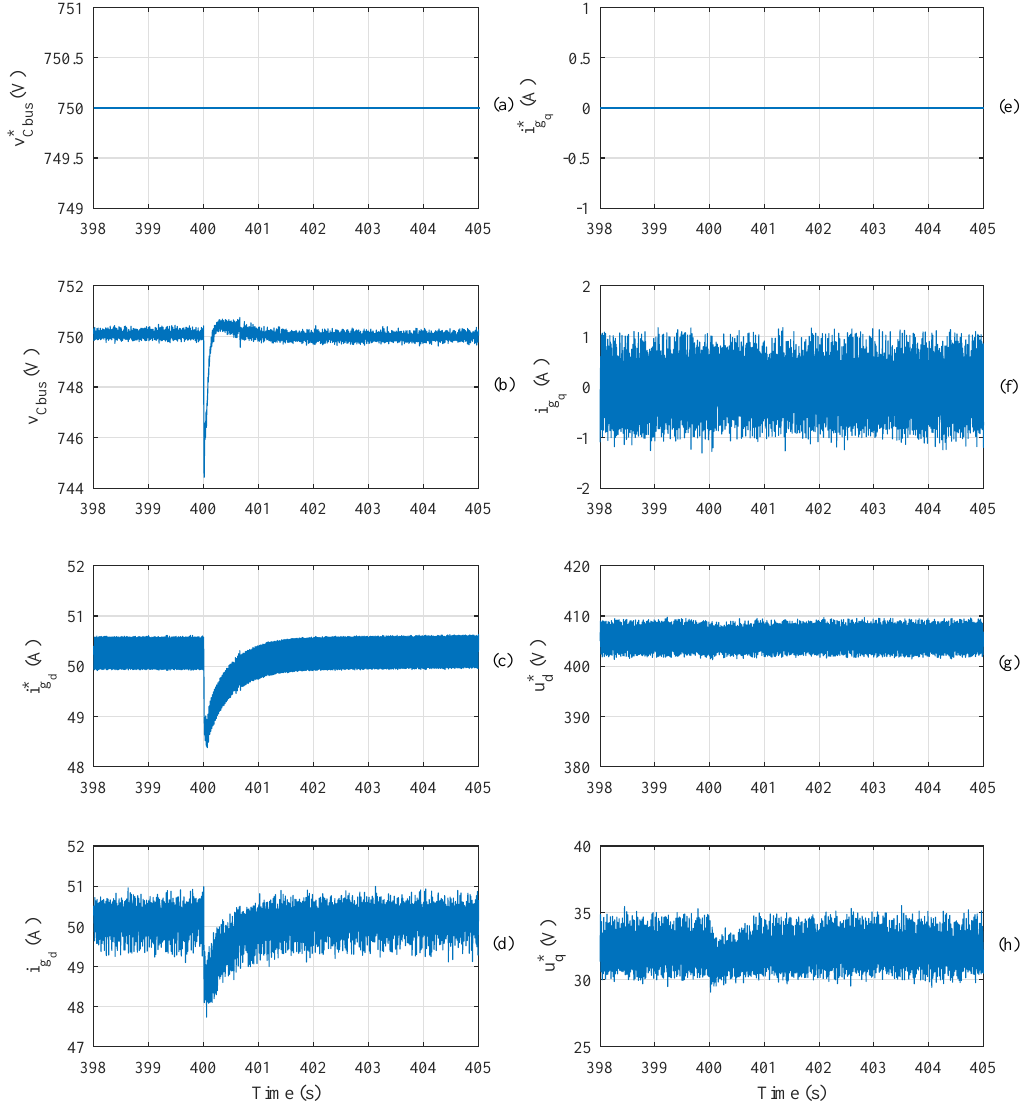
Figure 25. Results obtained for CPV 1 . Time responses of ( a ) reference of the voltage of the DC-link, v ∗ ; ( b ) voltage of the DC-link, v C ; ( c ) reference of the d -axis of the current, i ∗ g C bus bus ( e ) reference of the q -axis of the current, i ∗ g ; ( f ) current, i g ; ( g ) d component of the reference voltage of q q the converter, u ∗ ; and ( h ) q component of the reference voltage of the converter, u ∗ q d